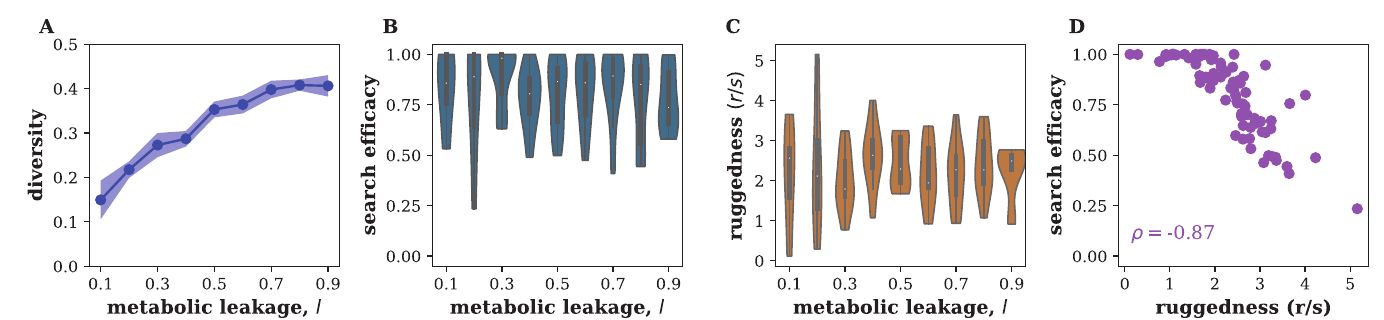
Fig 9. Ruggedness is predictive of search efficacy in models with cross-feeding. Cross-feeding altered the composition of microbial communities (A), but had no systematic effect on the success of the heuristic search (B) or ruggedness (C). Importantly, the search efficacy and ruggedness remained strongly anti-correlated in communities with cross-feeding (D). Simulated species pools had S = 12 species that leaked a fraction l of the resources they consumed as consumable byproducts. Community function used in panels B, C, D is the abundance of a focal species. A strong negative anti-correlation was found for other choices of community function as well (See S6 Fig). Only one out of 12 modeled resources was supplied externally; the rest were present only due to metabolic leakage. Each species was able to consume 6 resources. Ruggedness was quantified by r / s . See Methods for further simulation